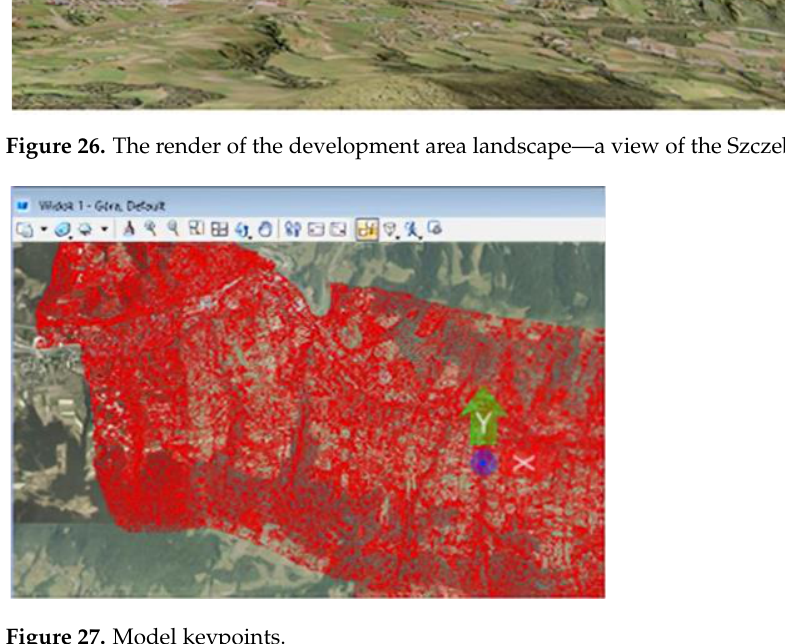
Figure 27. Model keypoints.